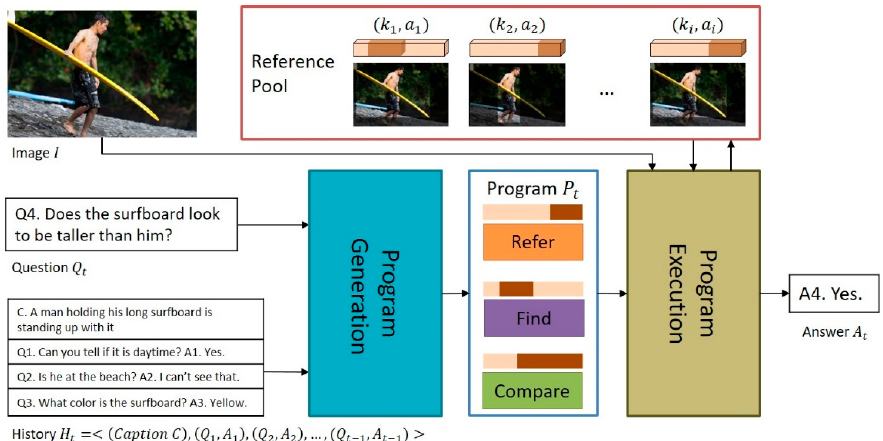
Figure 2. Overall structure of the proposed model.